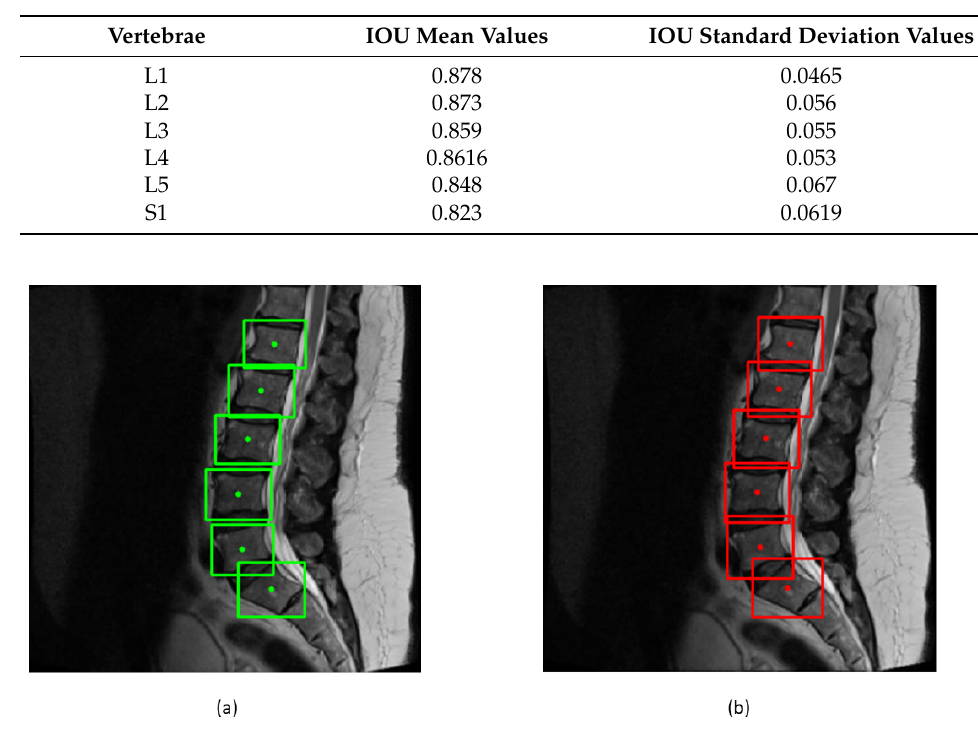
Figure 10. ( a ) Green bounding boxes represent the ground truth boxes with their centroids; ( b ) Red bounding boxes represent the predicted bounding boxes with their centroids.